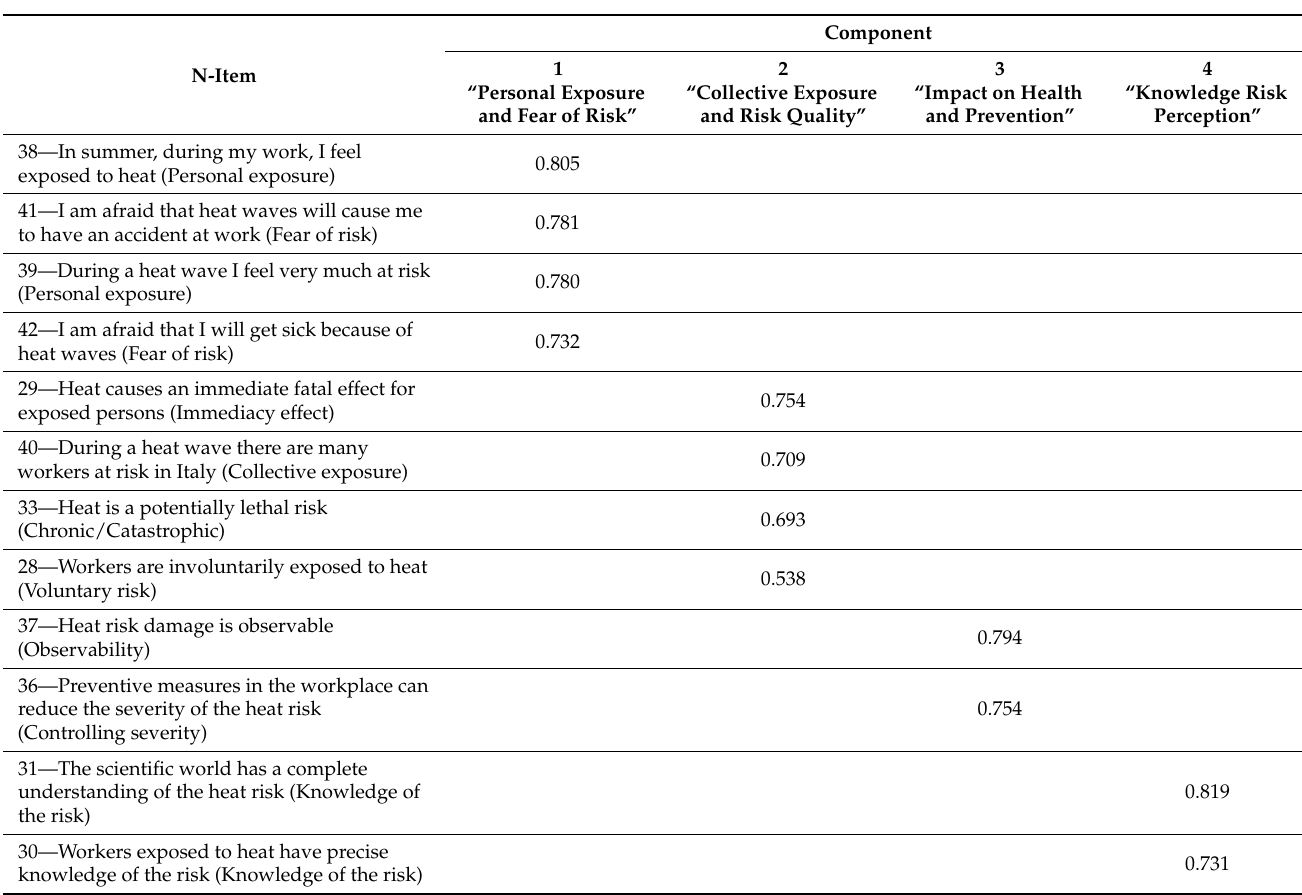
Table 2. Principal Component Analysis of section “Risk perception”. Extraction method: Principal Component Analysis. Rotation method: Varimax with Kaiser normalization.